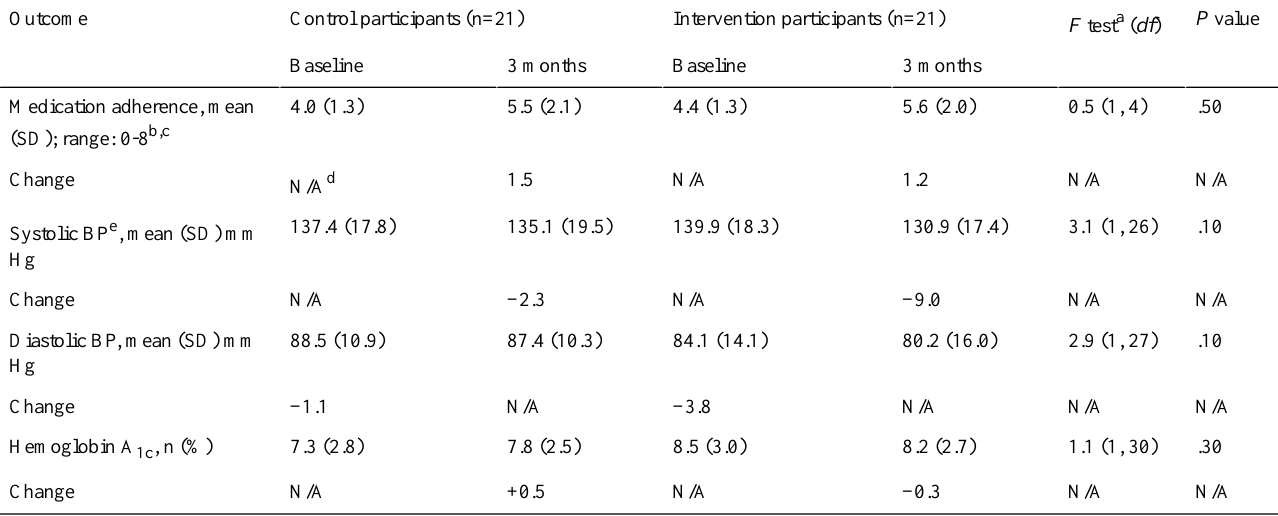
Table 3. Change in medication adherence blood pressure and hemoglobin A1c between baseline and 3 months by study